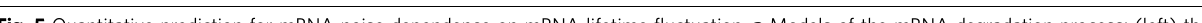
Fig. 5a: the sub-Poisson Michaelis – Menten process, the one-state Poisson process, and the two-state super-Poisson process 63 Each represents a renewal process that is characterized by the mRNA lifetime distribution shown in Fig. 5b, and the mRNA lifetime distribution varies depending on the model in question.